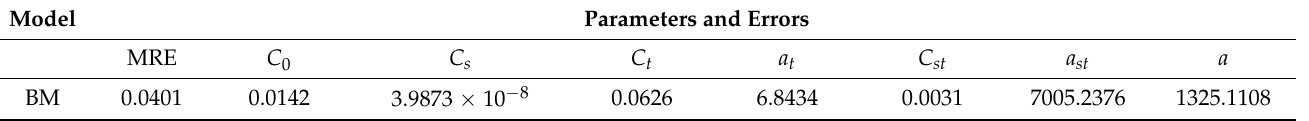
Table 1. Parameters and errors of the Bilonick model for daily average ozone concentration. Model Parameters and